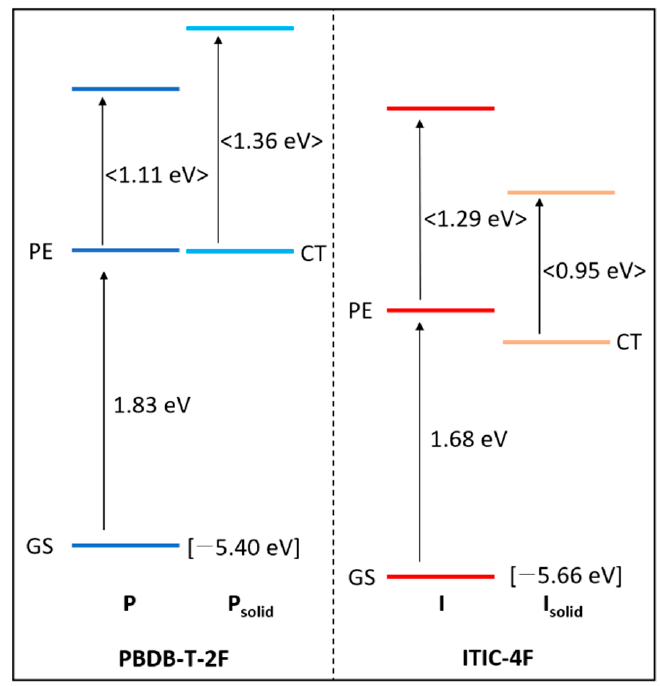
Figure 4. Energy level diagrams of P and I materials.